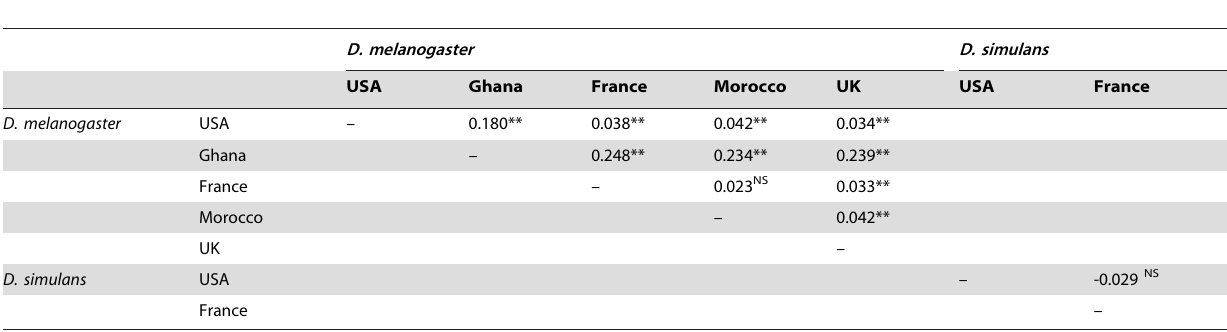
Table 3. Pairwise F ST estimates between populations and associated statistical significance (above diagonal), corrected for multiple tests using a Bonferroni